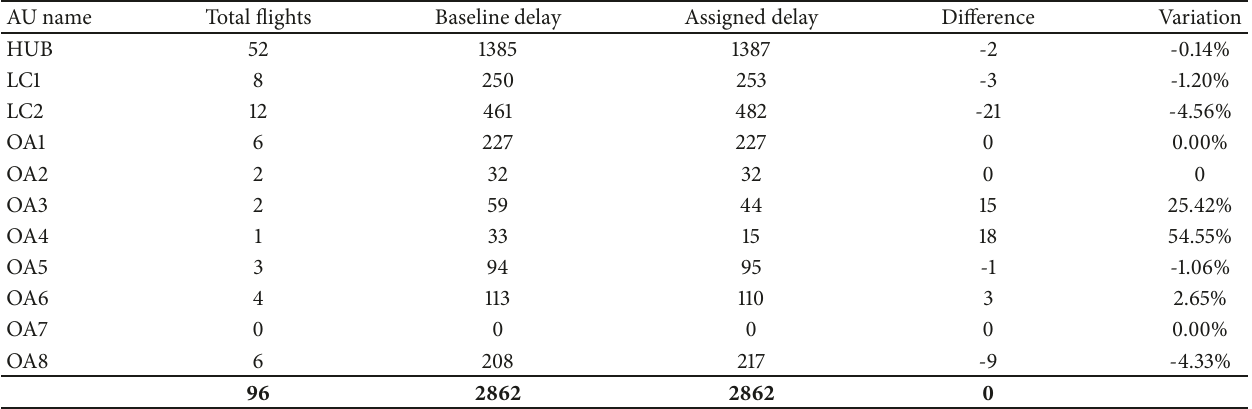
Table 8: Effect of sequence compression on the distribution of delay (case study 3).